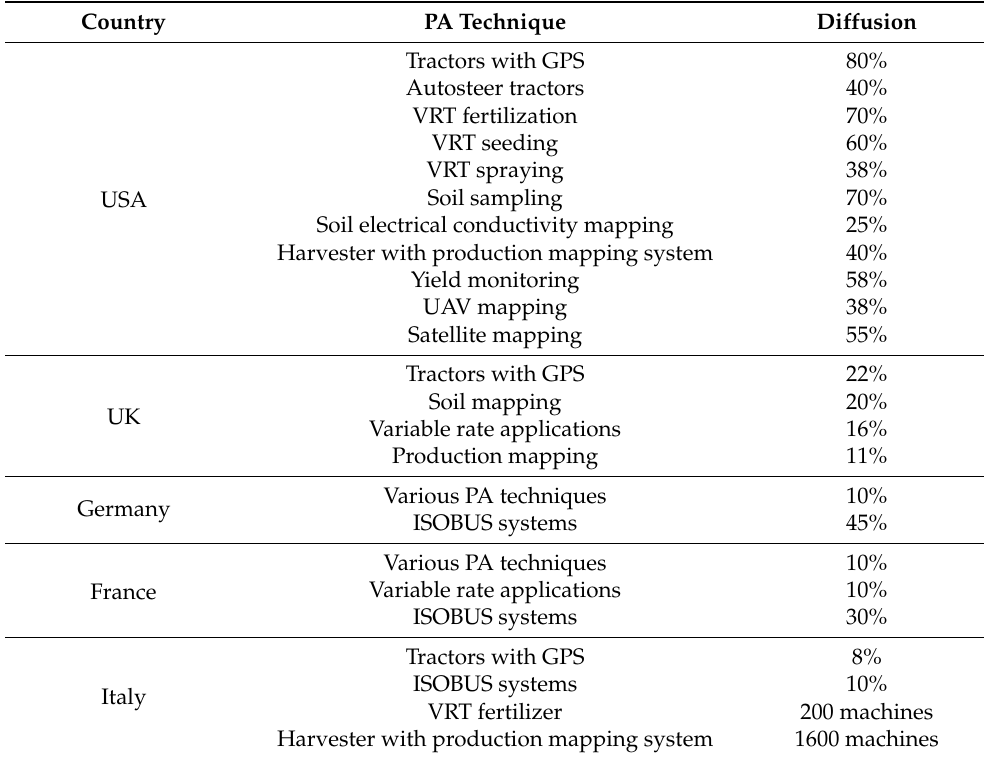
Table 2. PA world diffusion among farmers by technique